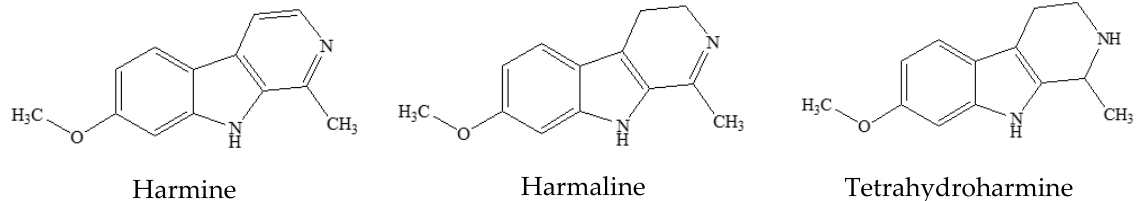
Figure 1. Structures of the main β -carbolines found in Banisteriopsis caapi.